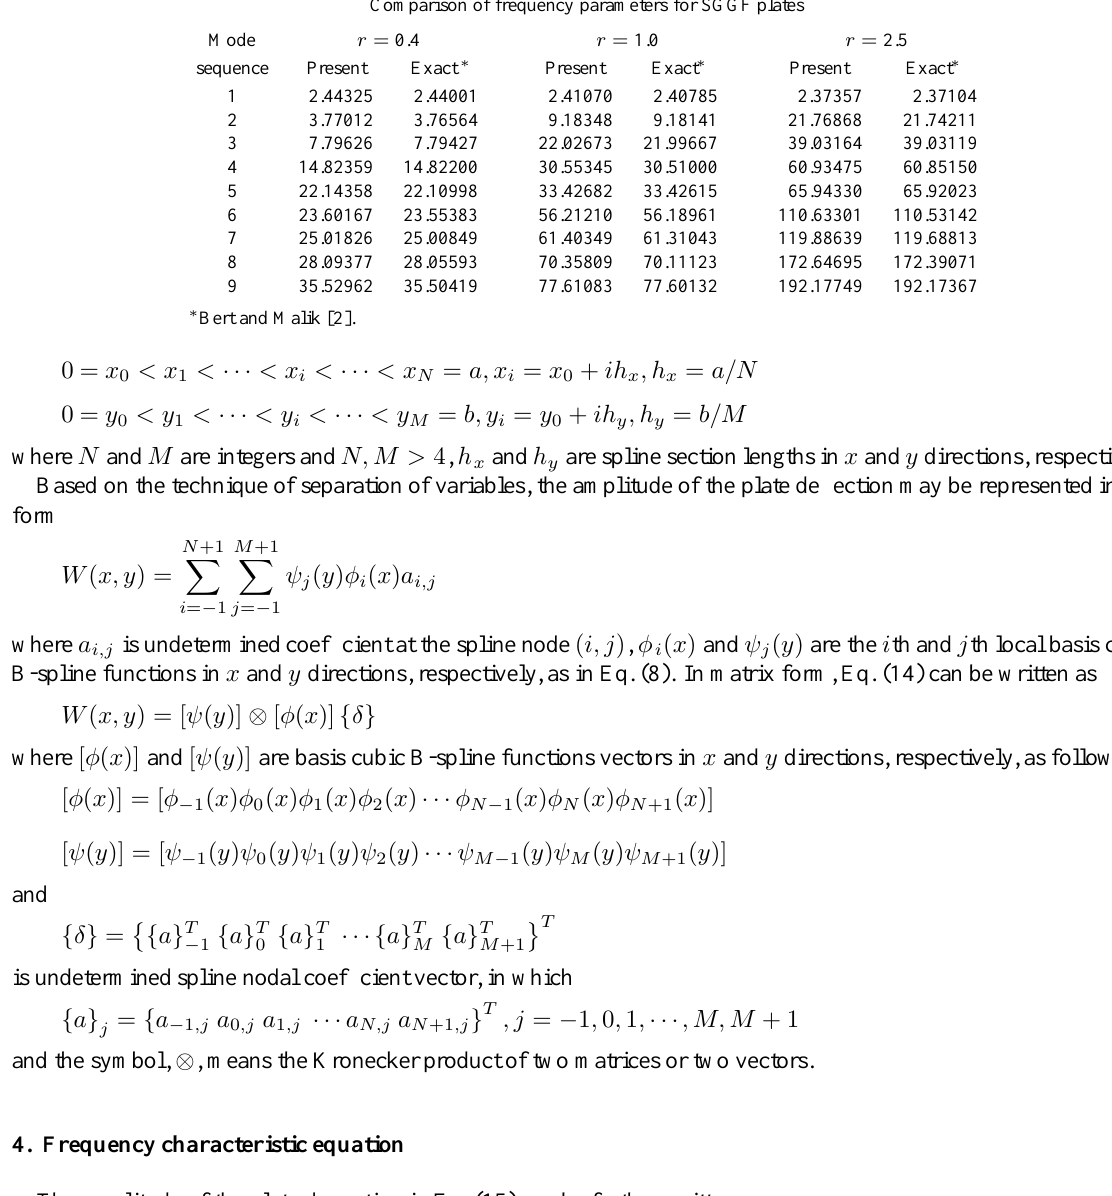
Table 3 Comparison of frequency parameters for SGGF